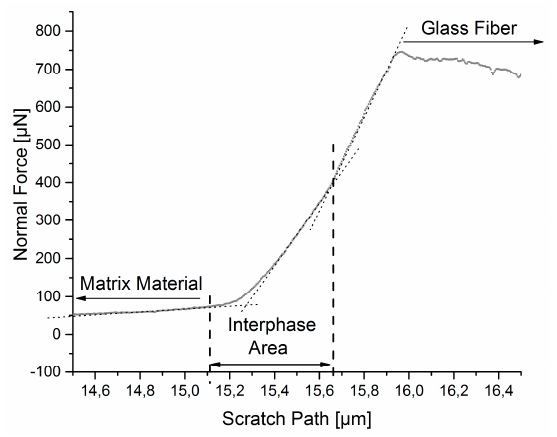
Figure 3. Measured normal force over the scratch path, identification of the interphase width using the slope method.